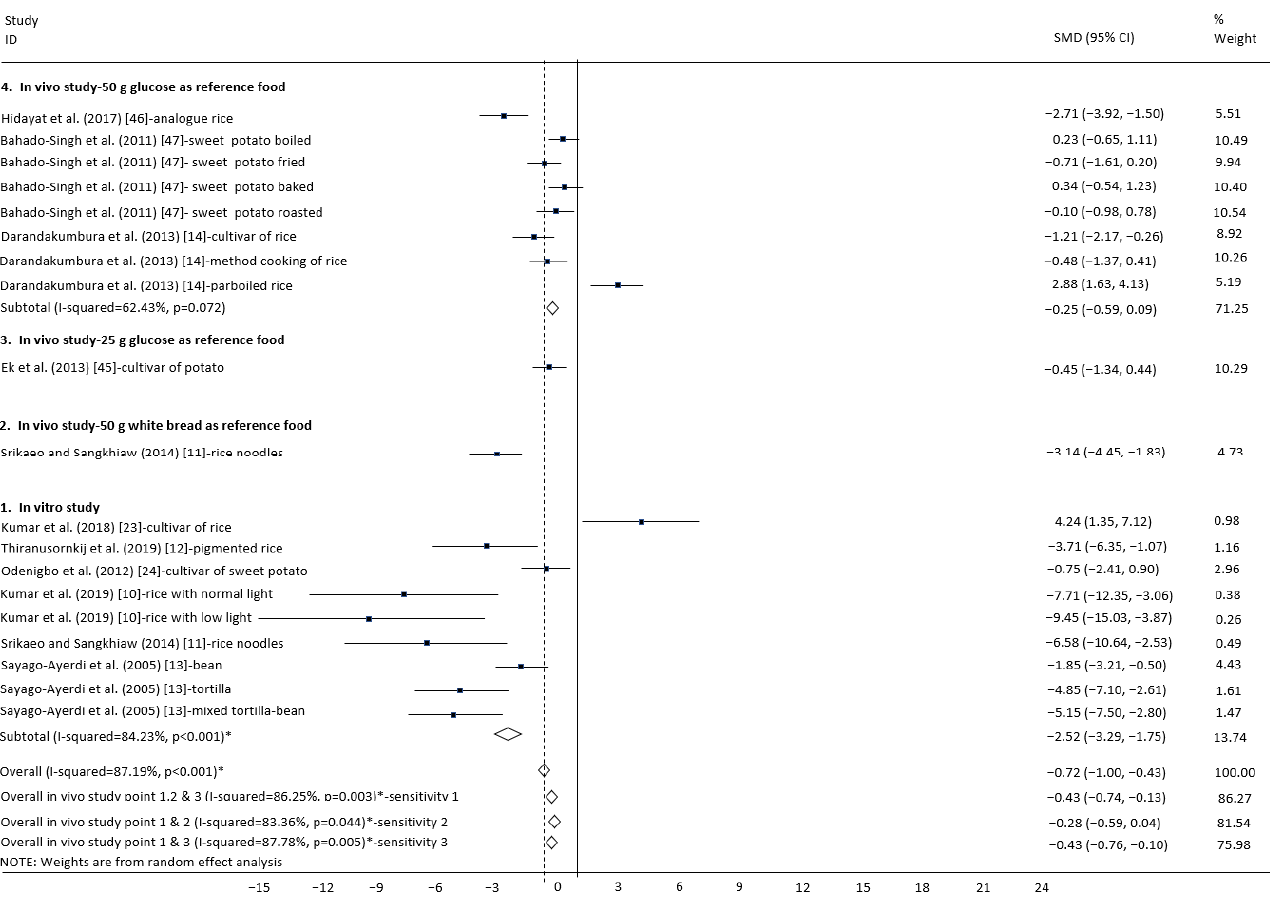
Figure 4. Subgroup analysis of the glycemic index according to the differing resistant starch content in carbohydrate foods. Standardized mean difference (SMD), confidence interval (CI), and point represent the estimated overall effect size (with 95%CIs) for each study. Positive values indicate relatively higher resistant starch content in carbohydrate foods. Negative values indicate relatively lower resistant starch content in carbohydrate foods.